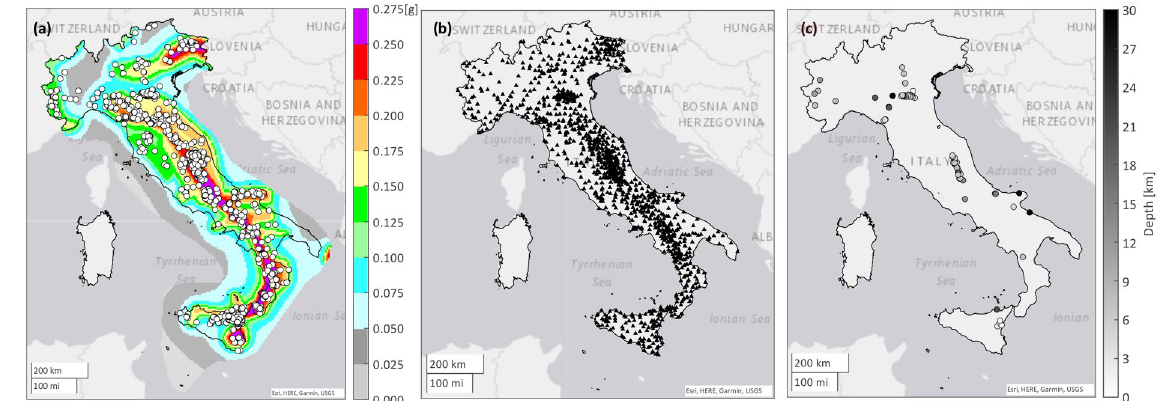
Figure 1. Epicenters of the considered earthquakes on the map of the PGA on rock with T r = 475 years used for seismic design ( a ); recording stations providing the basic data for the ShakeMap computations ( b ); epicenters and depth of the events causing PGA exceedance ( c ). (Maps created via MathWorks MATLAB R2021a; https:// it. mathw orks. com/ produ cts/ matlab.